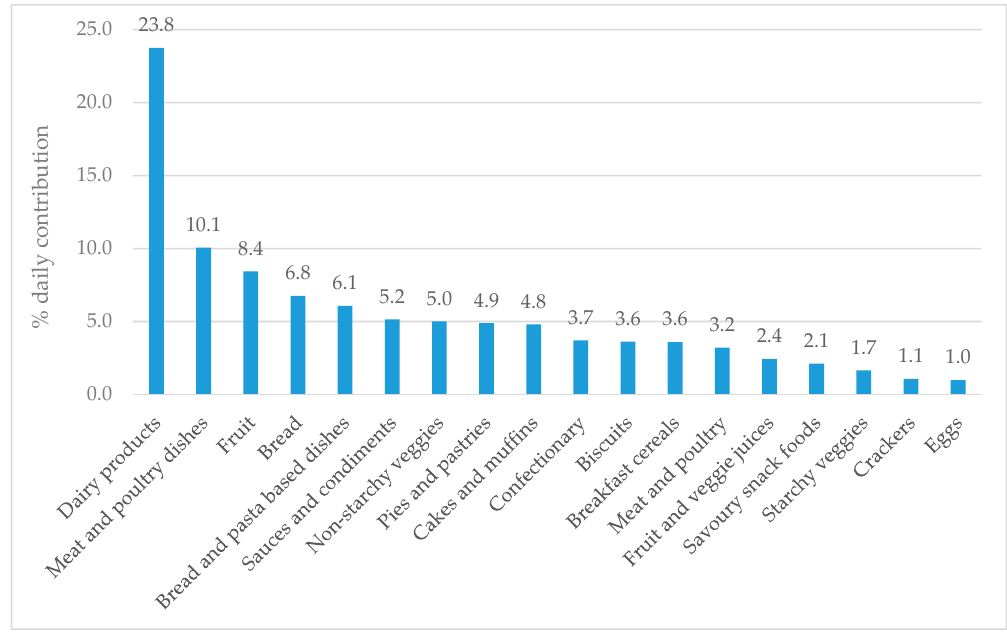
Figure 2. Daily contribution of potassium from 17 major food groups ( ≥ 1% daily contribution) among participating children ( n = 26).